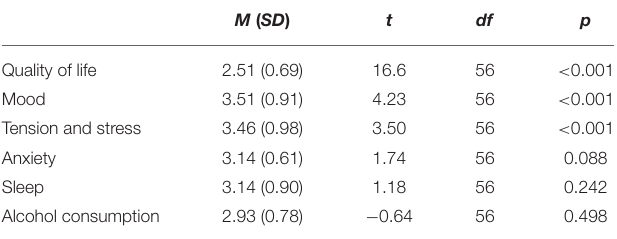
TABLE 2 | Reported changes in quality of life and mental health since the beginning of the